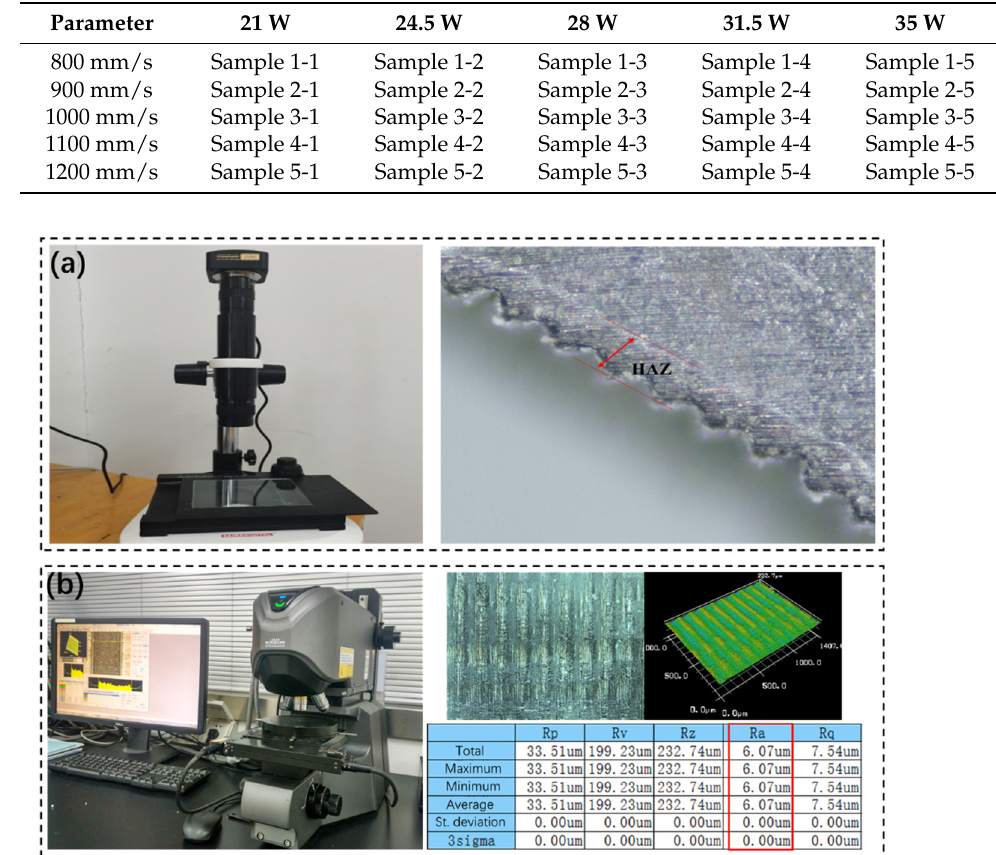
Figure 2. ( a ) Measuring the HAZ around the cutting hole with the microscope; ( b ) measuring the surface roughness with the laser confocal microscope. Table 2. Experimental design of CFRP laser cutting.